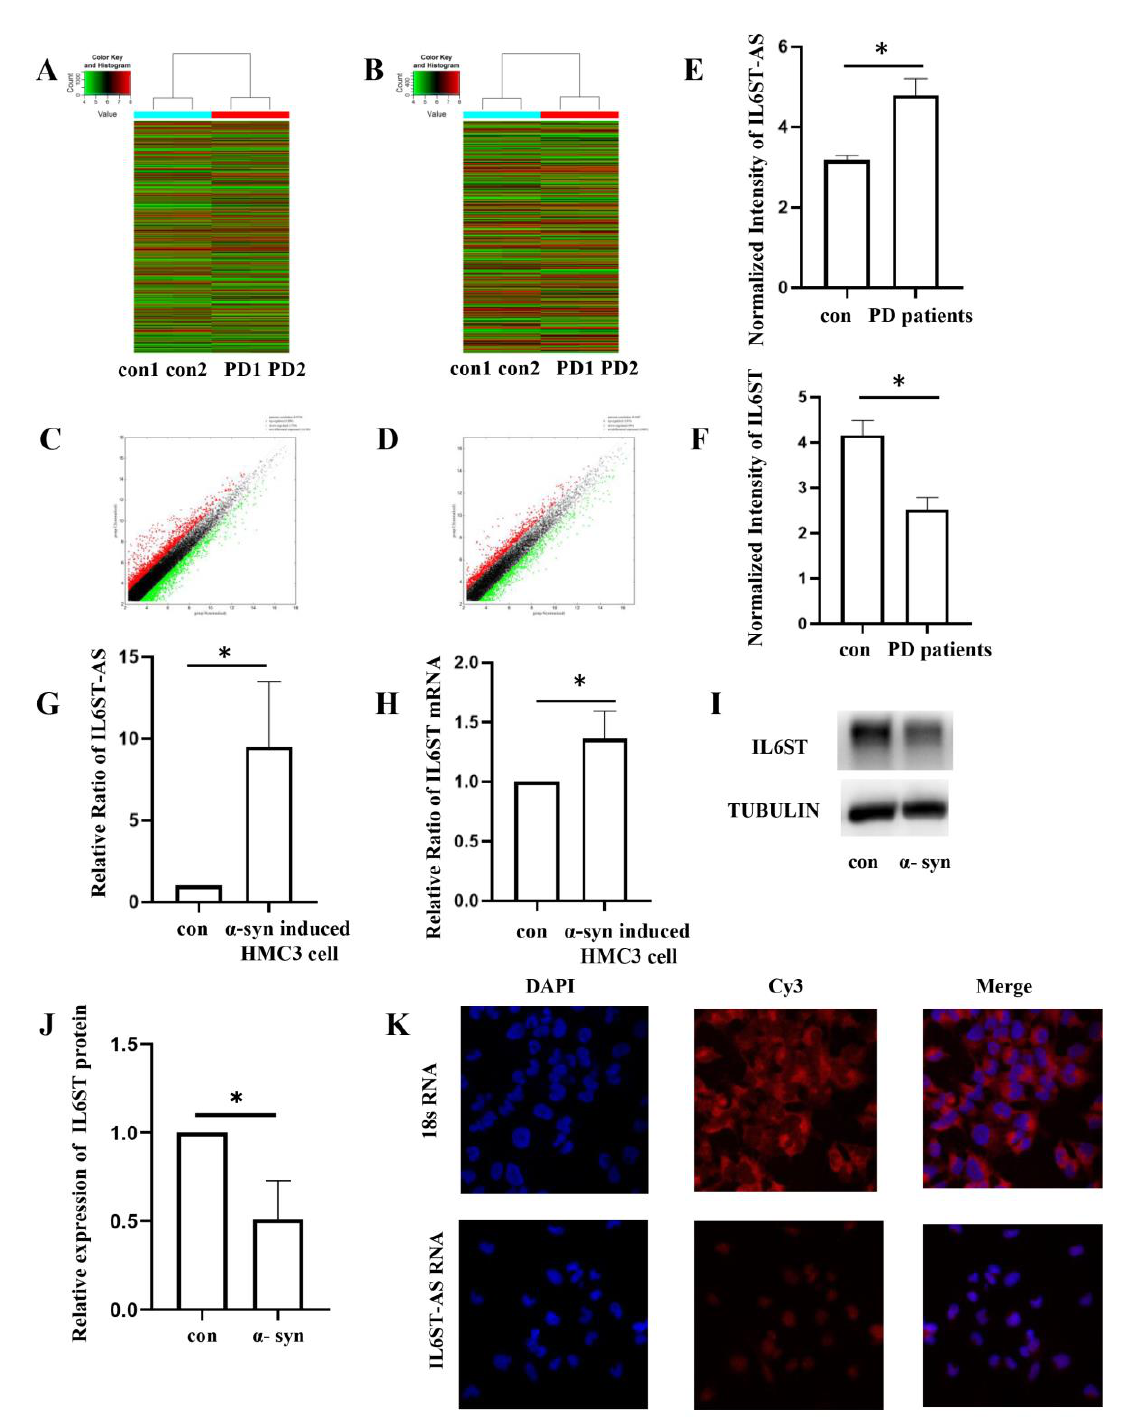
Figure 1. The expression level and sublocalization of IL6ST-AS and IL6ST in PD patients’ specimen and α -syn-induced HMC3 cells. Heat maps of the lncRNA group ( A ) and mRNA group ( B ) showing differentially expressed lncRNAs and mRNAs in the PD patients’ cerebrospinal fluid specimens. The bar code represents the color scale of the log-2-transformed values. Red parts indicate higher expression (FC > 1.5), and green parts indicate lower expression (FC > 1.5). The scatter plots of the lncRNA group ( C ) and the mRNAs group ( D ) were used to assess the variation between the chips. The x-axis and y-axis in the scatter plot represent the normalized signal values of each group (log-2 scaled). The black lines represent the fold change (FC < 1.5). Red points indicate higher